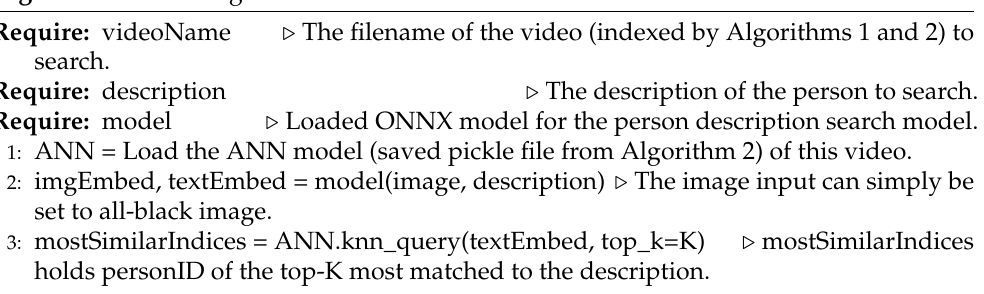
Algorithm 3 Searching The ANN